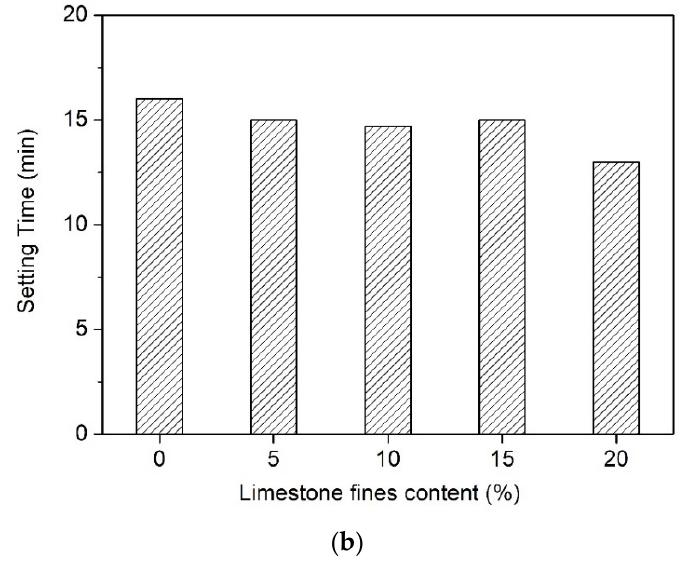
Figure 3. Fresh properties including the ( a ) fluidity and ( b ) setting time of MAPC mortar prepared by limestone sand with different contents of limestone fines (0–20% by weight of MAPC cement).